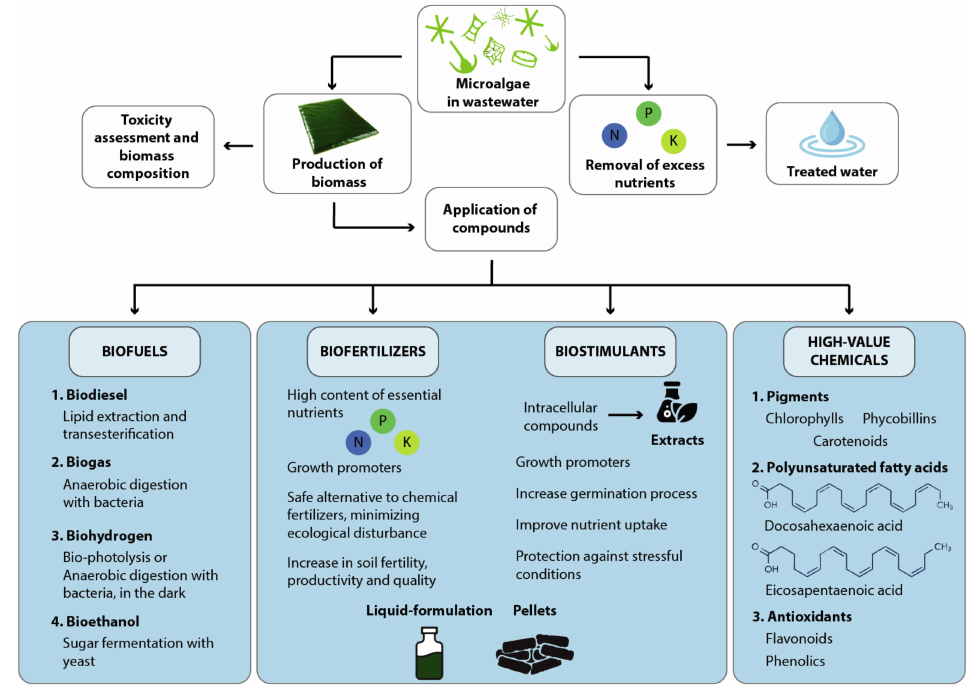
Figure 3. Bioproducts obtained from microalgal biomass produced in wastewater